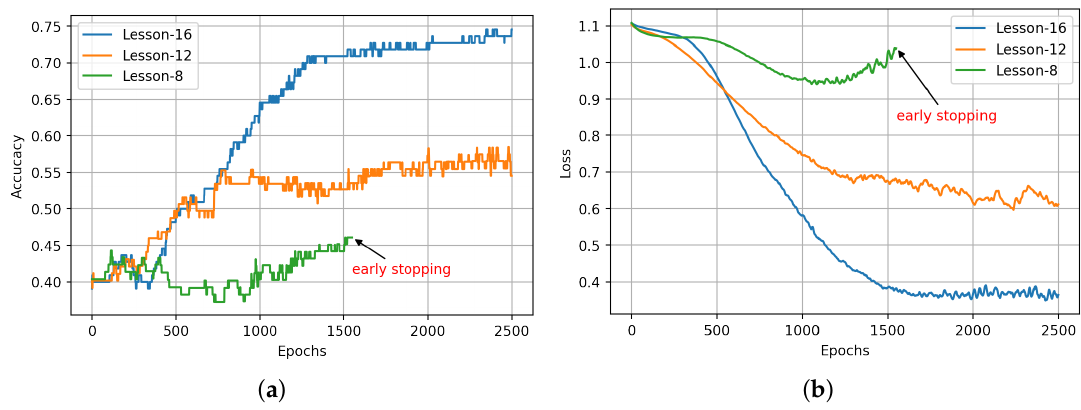
Figure 7. Training metrics of the proposed ANN model across 2500 epochs with early stopping. ( a ) Training accuracy; ( b ) Training loss